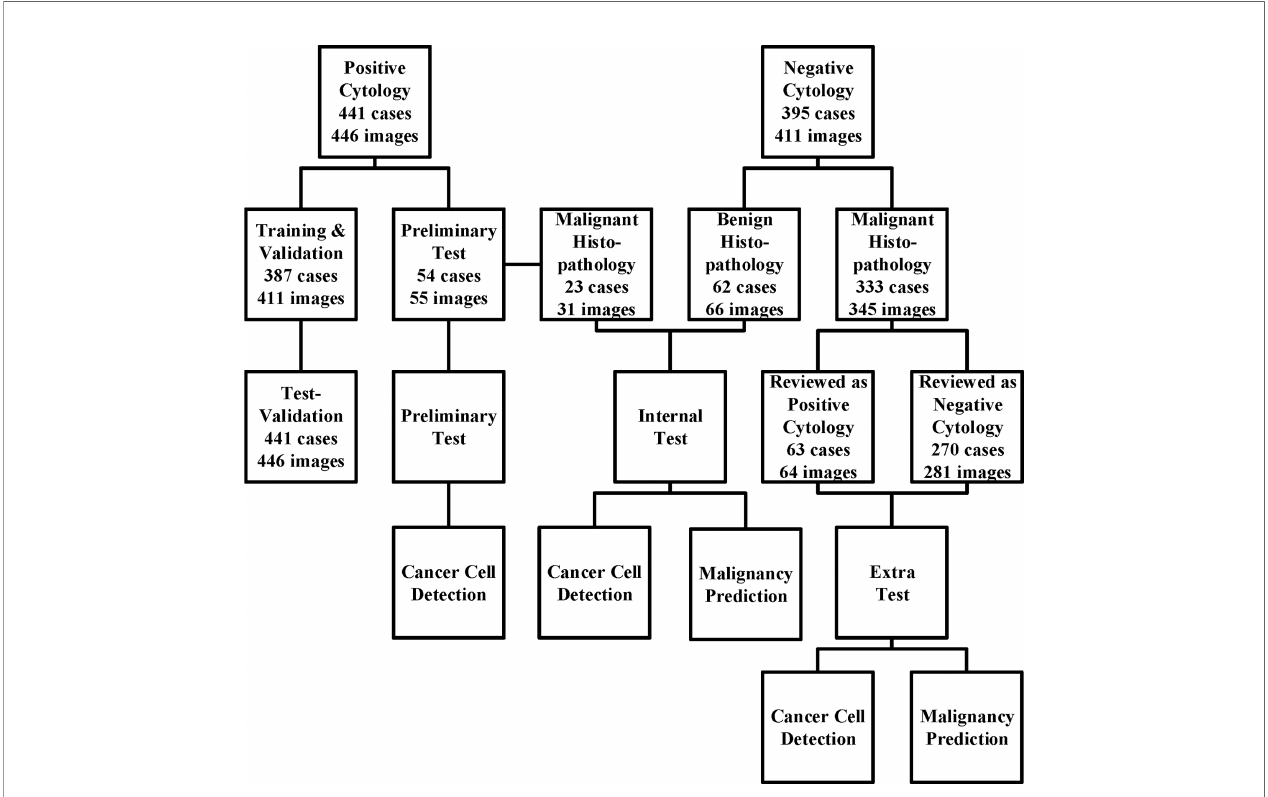
FIGURE 1 | The data acquisition process is illustrated here. We collected the cytology images retrospectively and consecutively from Sep 2014 to Jan 2020 and built a series of data sets for training, validation, and tests. For those who underwent surgeries within the next 1 year, surgical results were also followed. The preliminary test set was only used for cancer cell detection, while the internal and extra test sets were used for both cancer cell detection and malignancy